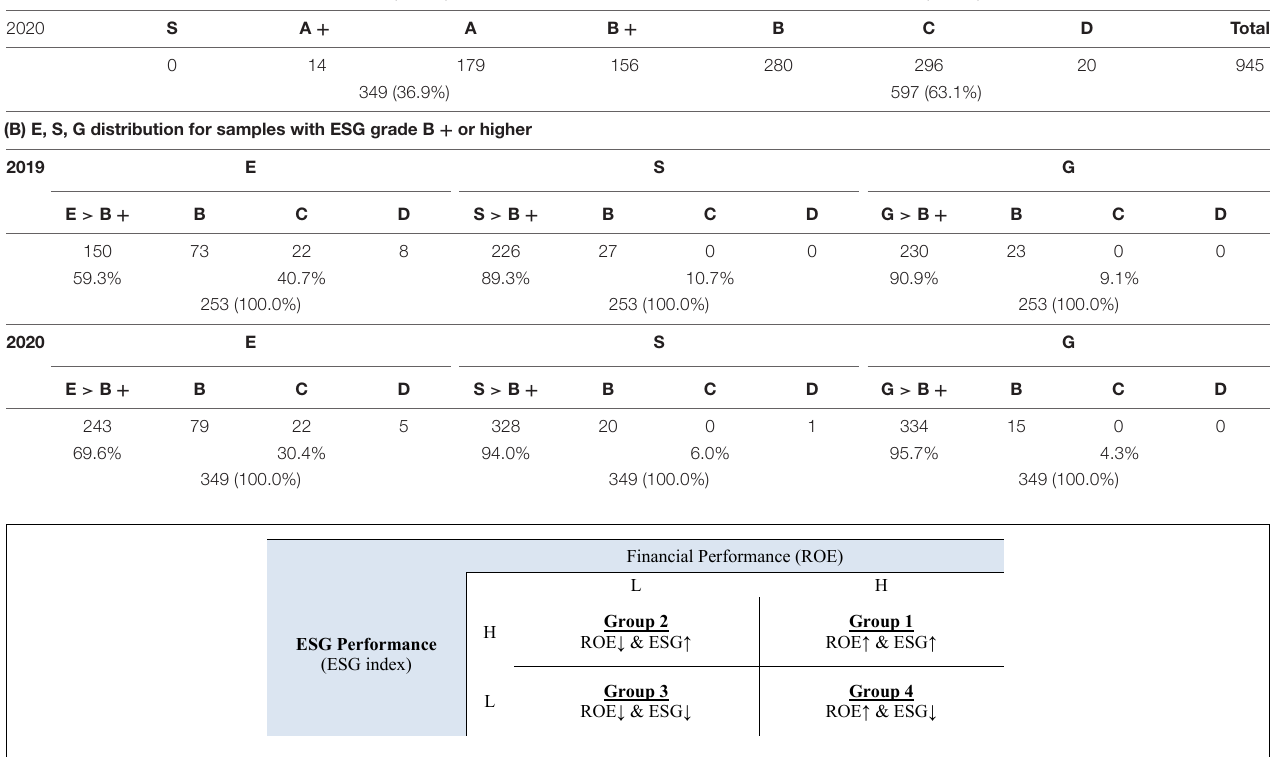
population ratio is statistically significant (G1 > G2), or the group 4 (G4) has a lower frequency than the group 3 (G3), and it is statistically significant (G4 < G3), it is supported that a firm with good financial performance actively conducts ESG